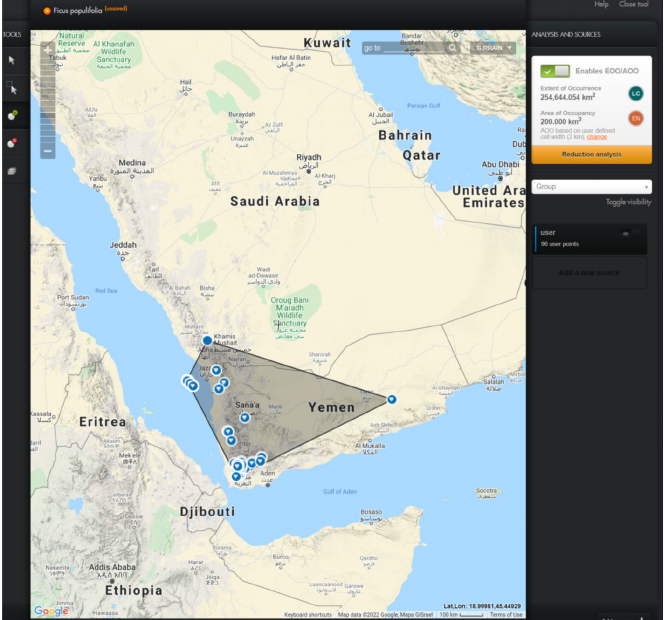
Figure 15. Point occurrence map of Ficus populifolia in the Arabian Peninsula based on field observa- tions and literature, generated by the GeoCAT software